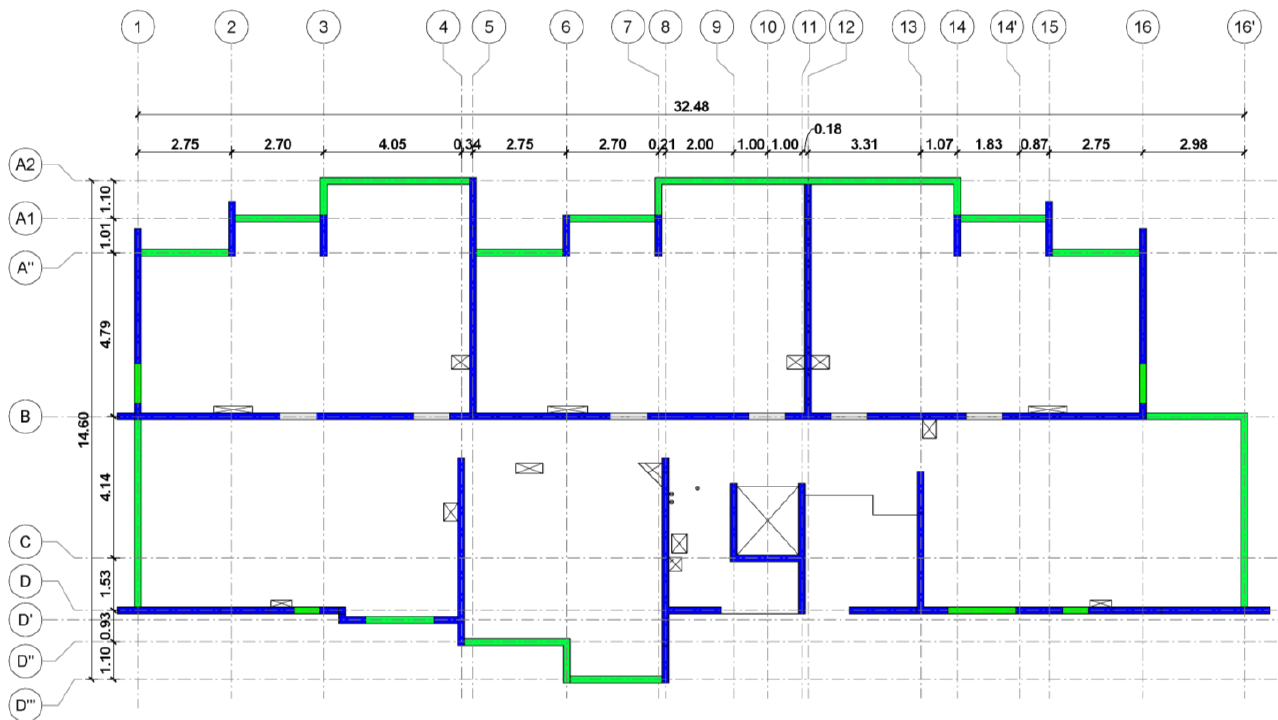
Figure 2. Typical plan view of the building, with the shear walls marked in blue and the beams in green.